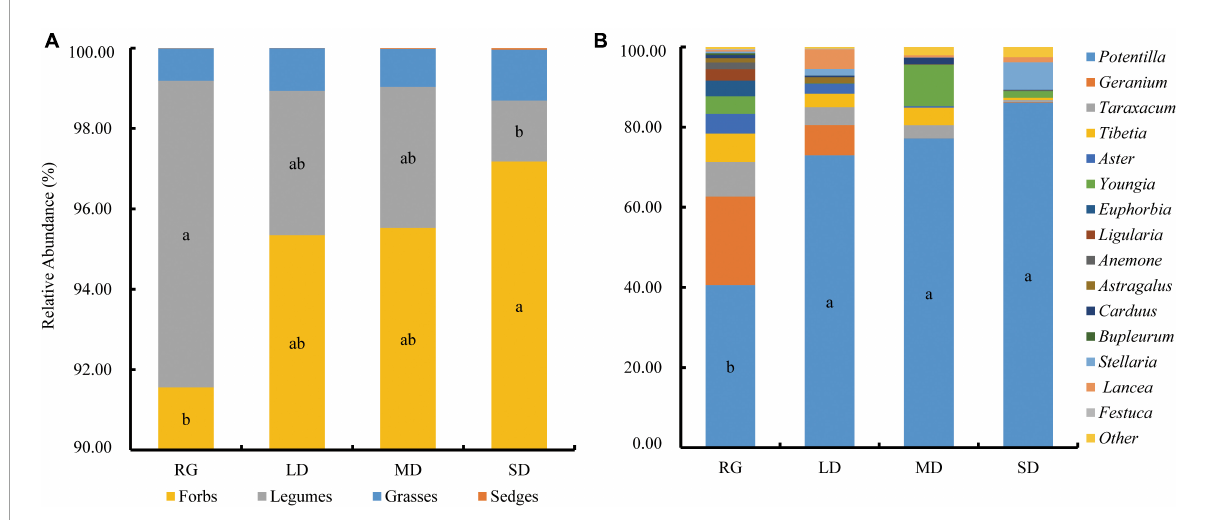
FIGURE6 Food composition and proportion of plateau zokors with different functional groups (A) and plants at the genus level (B) . LD, lightly degraded grassland; MD, moderately degraded grassland; SD, severely degraded grassland; RG, reseeded grassland. Different letters indicate significant differences between groups ( P <